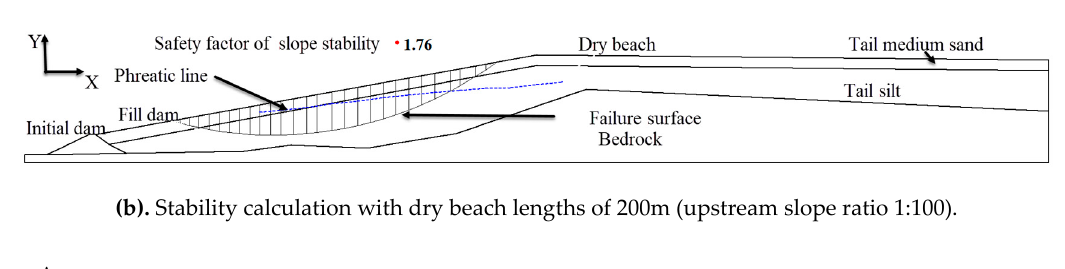
(a). Stability calculation with dry beach lengths of 100m.